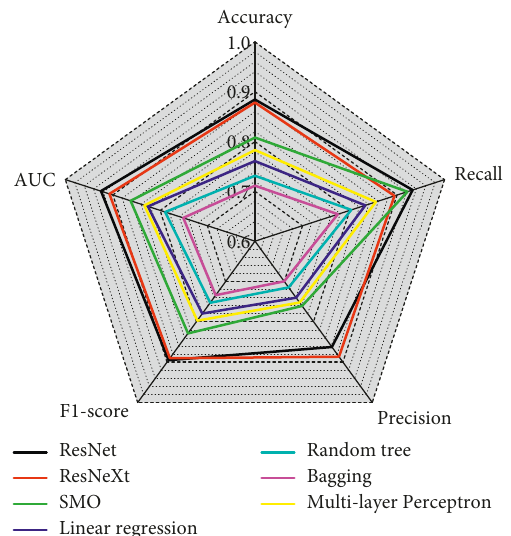
Figure 7: Radar graph representing the comparative analysis of performance parameters of various